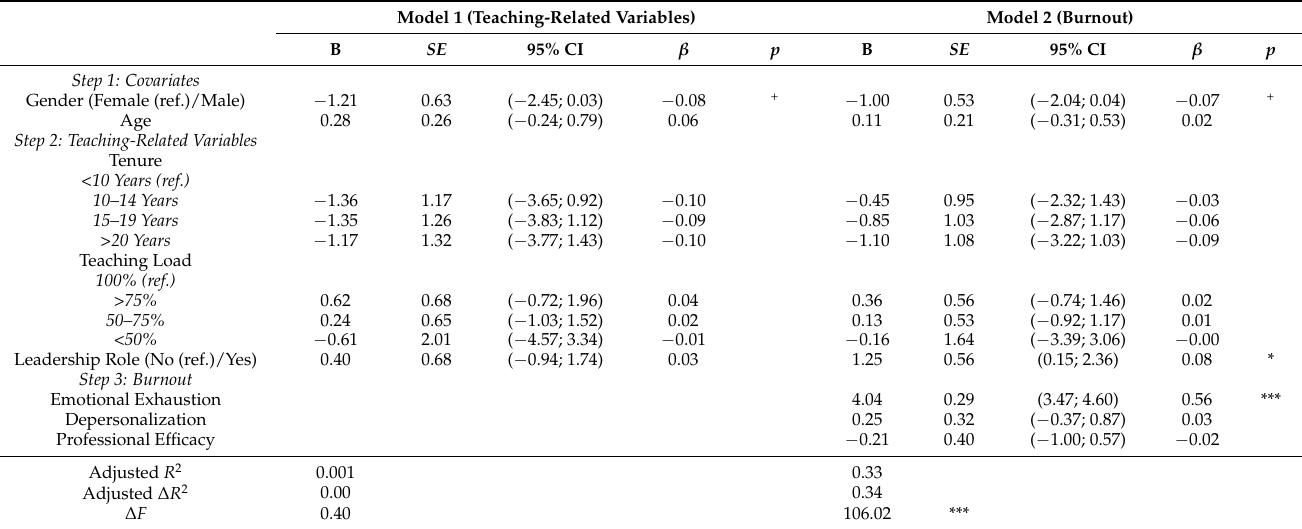
Table 7. The role of burnout in psychological well-being (stepwise hierarchical regression with GHQ-12 as a dependent variable).